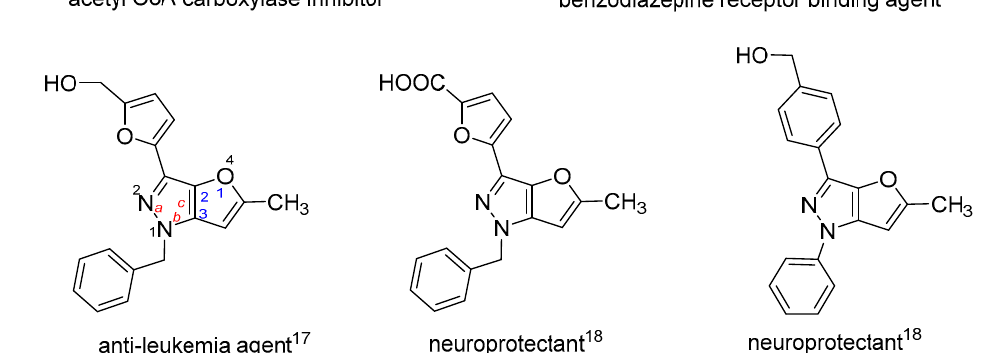
Figure 1. Examples of bioactive pyrano[2,3- c ]pyrazoles, pyrano[3,2- c ]pyrazoles, and furo[3,2- c ]pyrazoles.